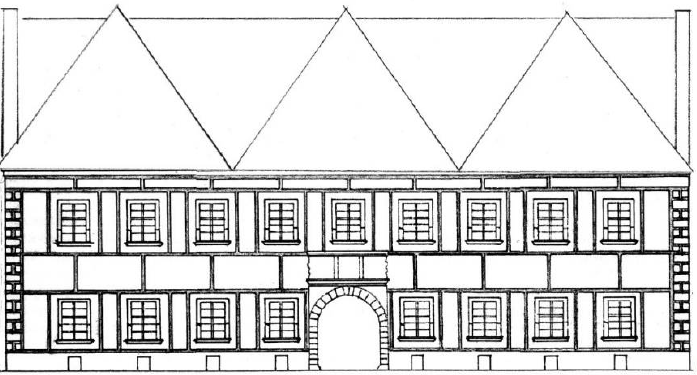
Figure 19. The remains of the sgraffito decoration and the preserved iconographic materials allowed reconstruction of the decorations in a frame arrangement on the facades of the palace in Siestrzechowice. Author’s study.